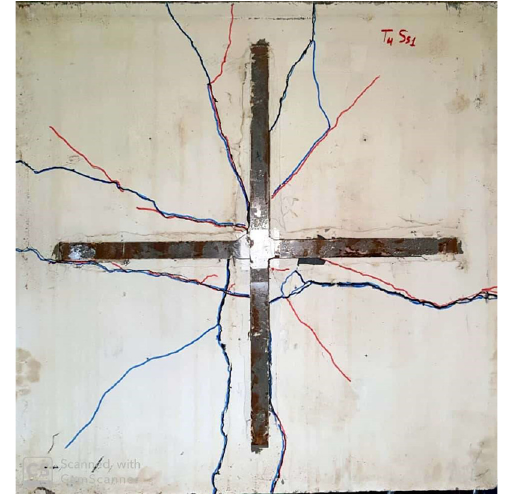
Figure 12: Crack pattern under impact - fl exural loads of the T4SS1 slab bottom face.